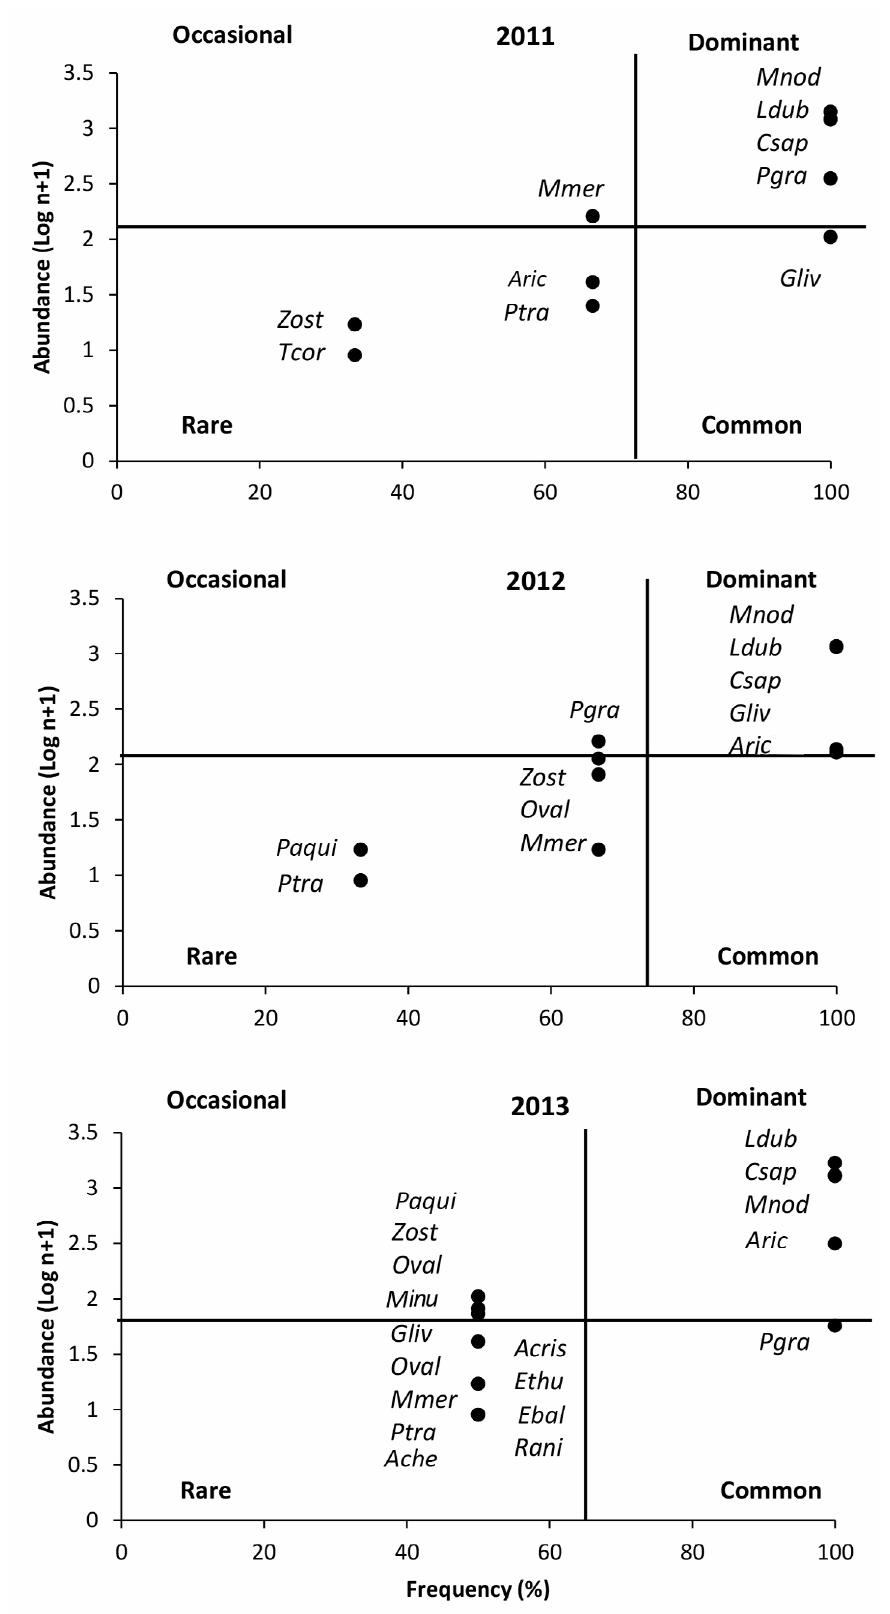
Figure 2. Relation between the frequency of occurrence and density of brachyuran zoea I per year. Species name abbreviations are shown in Table